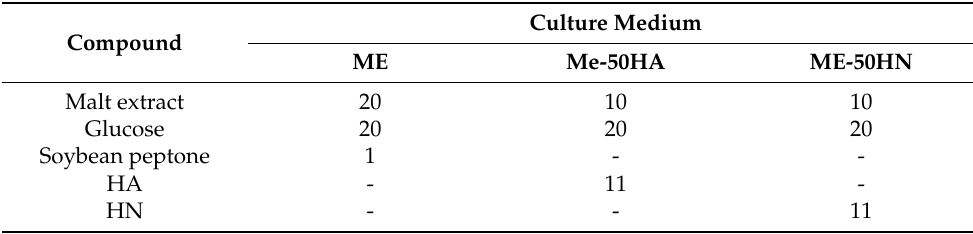
Table 3. Composition of the culture media (g/L) tested based on MEA for the evaluation of HA and